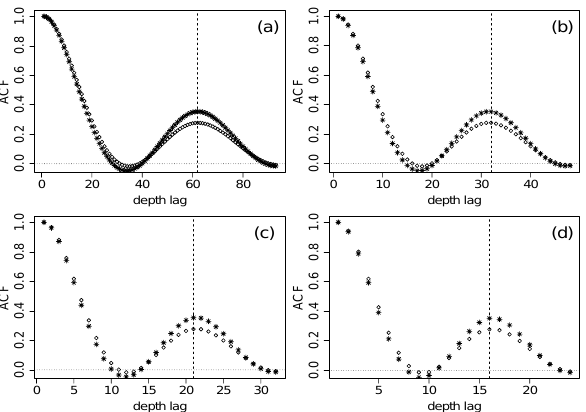
Fig. 9. A stretch of the classified log NH 4 signal (fourth thinning) from the NGRIP ice-core (1442.25–1442.87m), for ν = 0 . 5. Points within an issue are black, points within peaks coloured red, de- scending points orange, troughs blue, and ascending points green. (a) The log signal with µ and µ ± σ shown as dotted lines. (b) The standardised signal s .